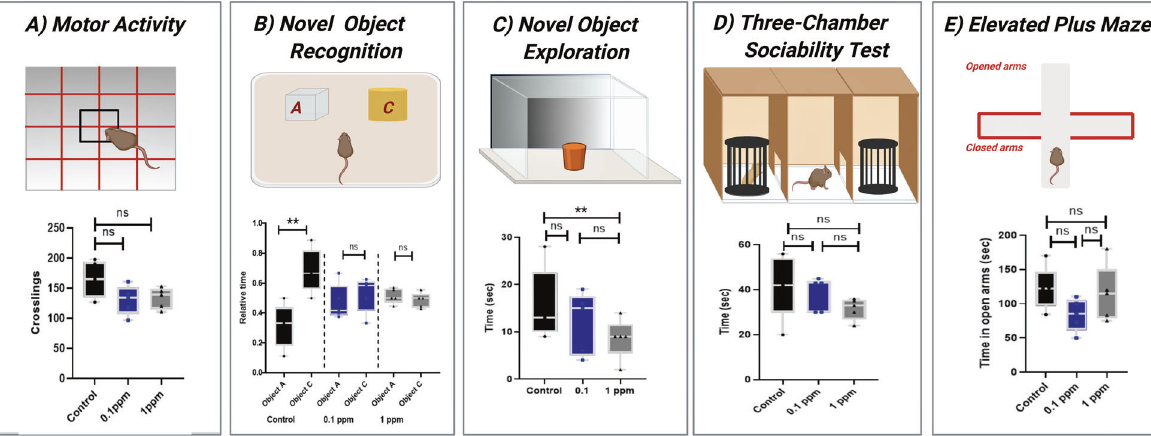
treated groups and control mice. E An elevated plus-maze test showed no difference among the three groups.